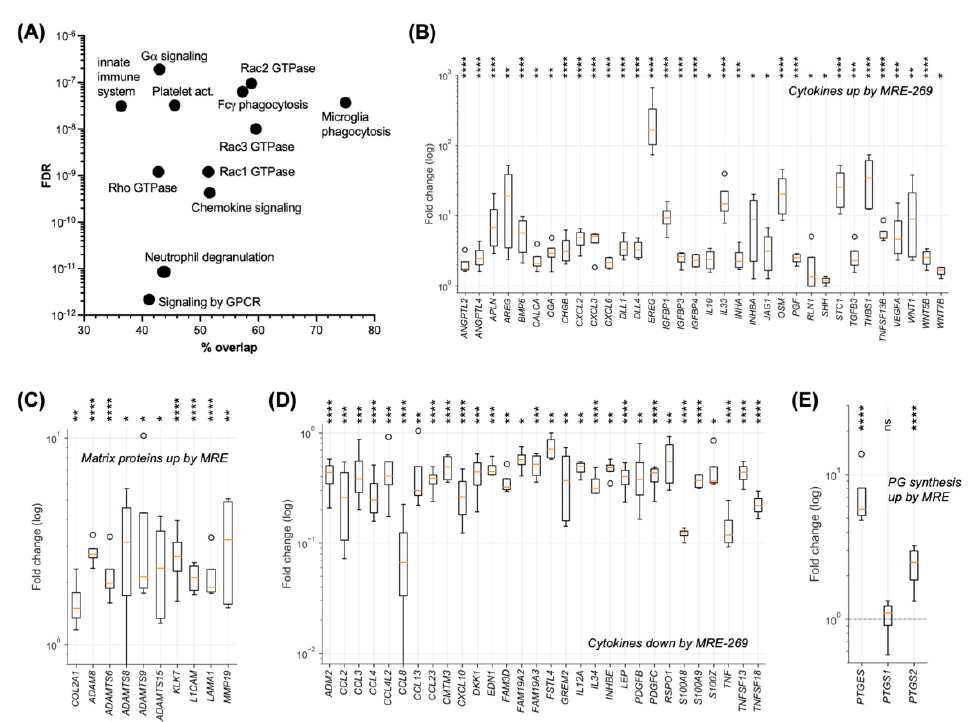
Figure 5. Functions of genes regulated by the PGI 2 analog MRE-269. ( A ) Functional annotation of MRE-269-regulated genes (as in Figure 4A) using the over-representation tool of ConsensusPathDB [32]. The plot depicts the top 12 (by FDR) specific terms. Overlap: percentage of genes in the query set compared to the set representing the respective term. ( B ) Cytokine genes associated with the term “metastasis” in the genecards.org database and upregulated by MRE-269 (FDR < 0.05). ( C ) Metastasis-associated genes coding for ECM components and proteases of the TME significantly upregulated by MRE-269. ( D ) Cytokine genes significantly downregulated by MRE-269. ( E ) Genes involved in prostaglandin synthesis significantly upregulated by MRE-269. Boxplots show the median (line), upper and lower quartiles (box), range (whiskers) and outliers (circles). * FDR < 0.05; ** FDR < 0.01; *** FDR < 0.001; **** FDR < 0.0001; ns, not significant by EdgeR paired test.